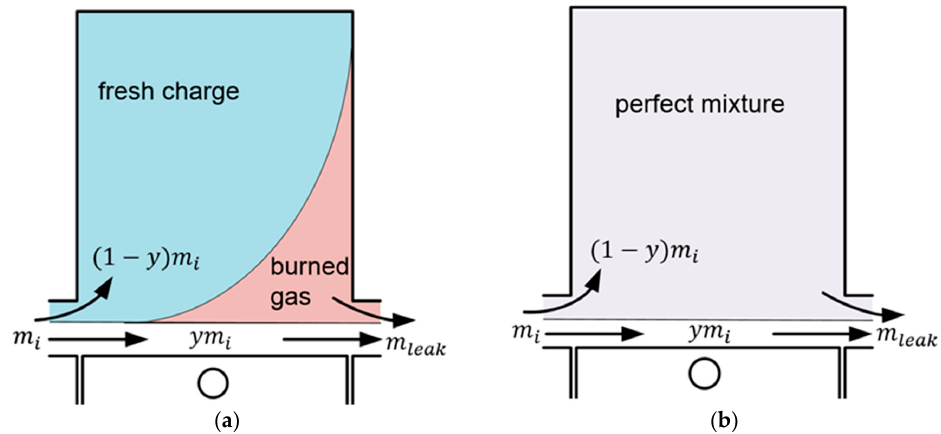
Figure 2. Phase/zone concept of the Benson/Bradham model: ( a ) Phase I; ( b ) Phase II.